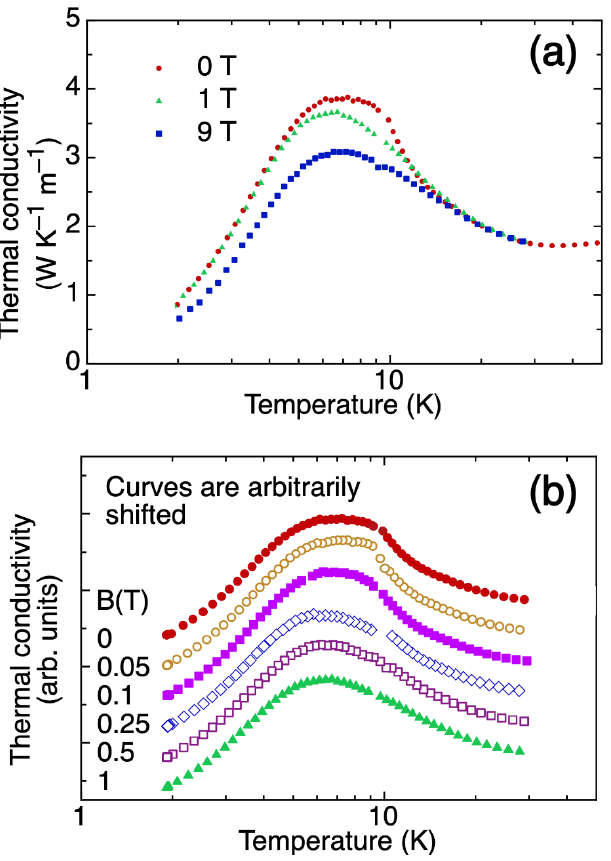
Figure 4. Thermal conductivity as a function of temperature for ( a ) 0 T, 1 T, and 9 T magnetic fields, and ( b ) for magnetic fields between 0 and 1 T, showing the gradual flattening of the cusp below 10 K.